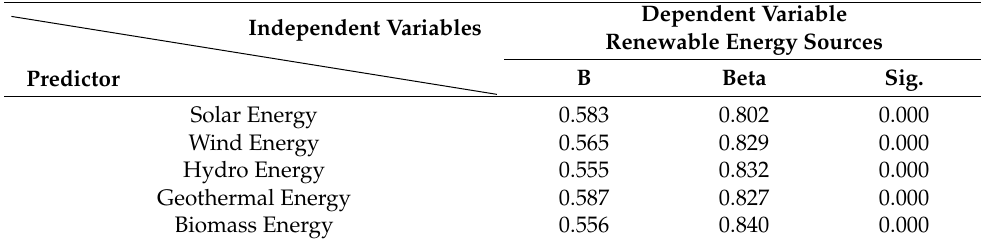
Table 11. Regression analysis renewable energy sources with factors. Dependent Variable Independent Variables Renewable Energy Sources B Beta Sig. Predictor Solar Energy 0.583 0.802 0.000 Wind Energy 0.565 0.829 0.000 Hydro Energy 0.555 0.832 0.000 Geothermal Energy 0.587 0.827 Biomass Energy